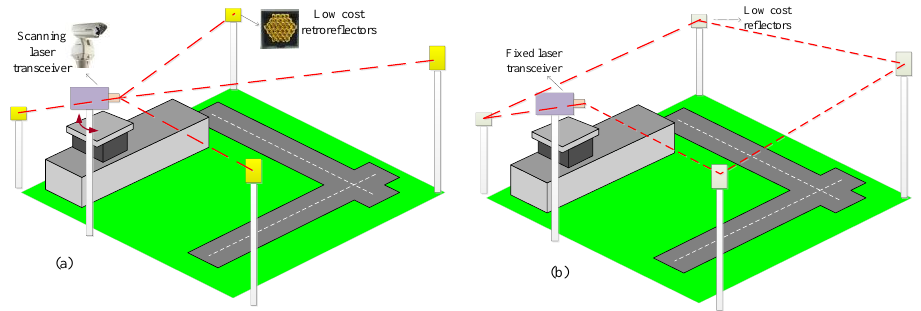
Figure 3. LaserWarn system [98] for threat cloud detection and facilities protection by constructing an “optical fence” with ( a ) laser transceiver scanning mode and ( b ) laser transceiver fixed mode.